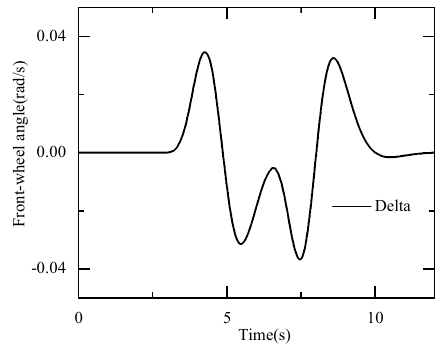
Figure3. Front-wheel angle. Figure 3. Front-wheel angle.